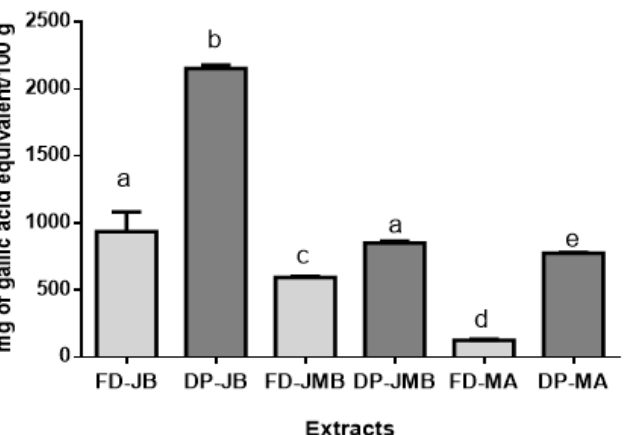
Figure 1. Total phenolic compounds of freeze-dried (FD) and dried peel powders (DP) extracts of M. jaboticaba (FD- MJ and DP-MJ), S. cumini (FD-SC and DP-SC), and S. malaccense (FD-SM and DP-SM). Results are expressed as mean ± standard deviation; means with different letters in the same line are significantly different ( p < 0.05, Tukey’s test).